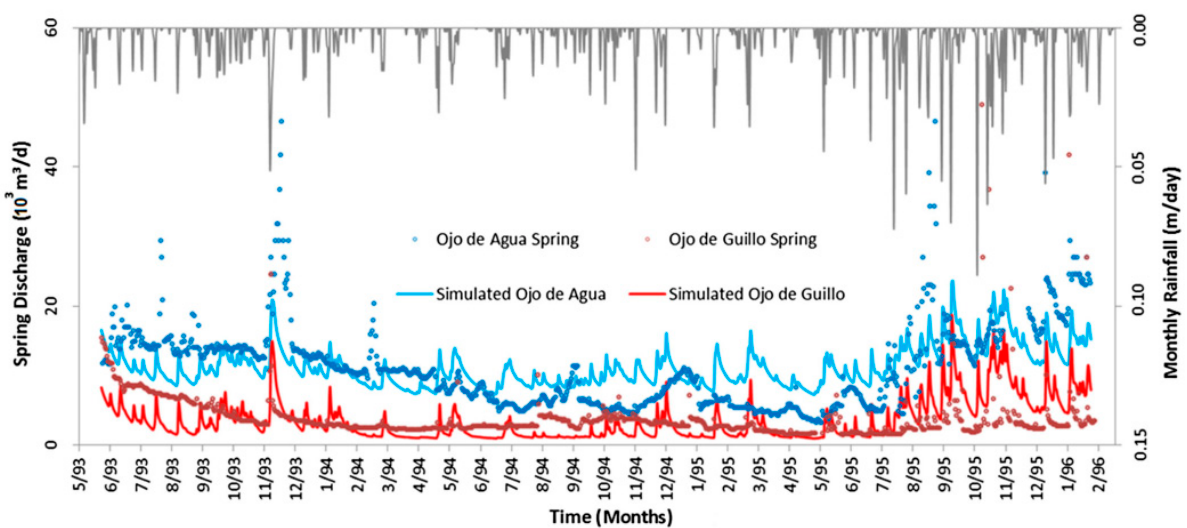
Figure 19. A comparison of the daily rainfall hydrograph with the daily mean discharge hydrograph, both simulated and observed, for the Oje de Agua spring in Vega Baja and the Oje de Guillo spring in Manati between June 1993 and February 1996 [3].